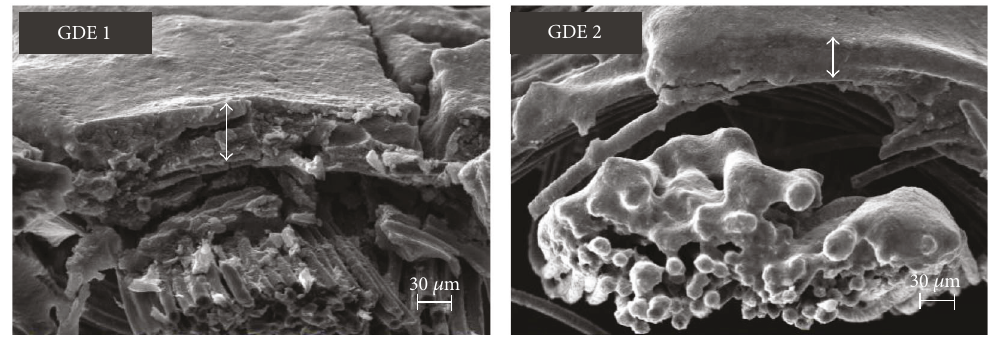
Figure 3: SEM images of the cross section of the coating layers of GDE1 and